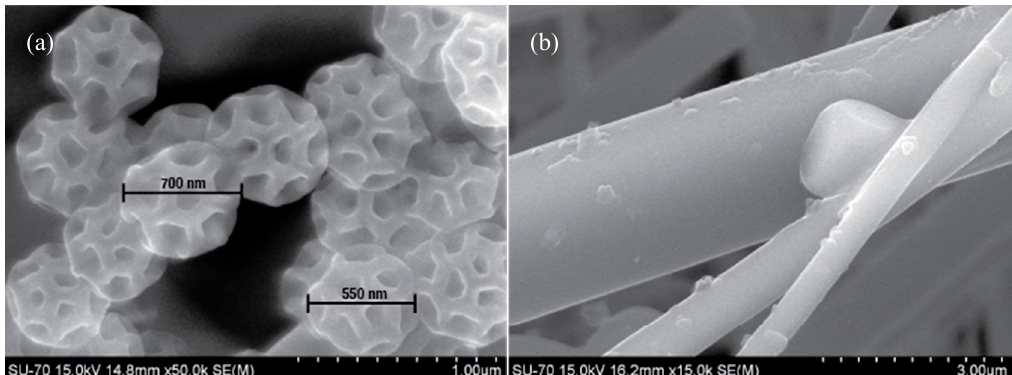
Figure 5. SEM imagens of ( a ) brochosomes, and ( b ) salt (NaCl) particles in indoor samples.